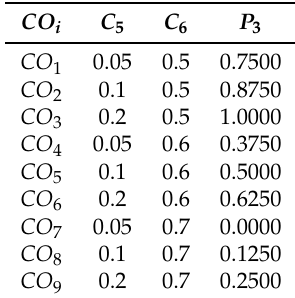
Figure 14. Visualization of triangular fuzzy numbers for Failures per round assessment model ( P 3 ). Table 7. Overview of characteristic objects CO , vector P values for the Failures per round assessment model.